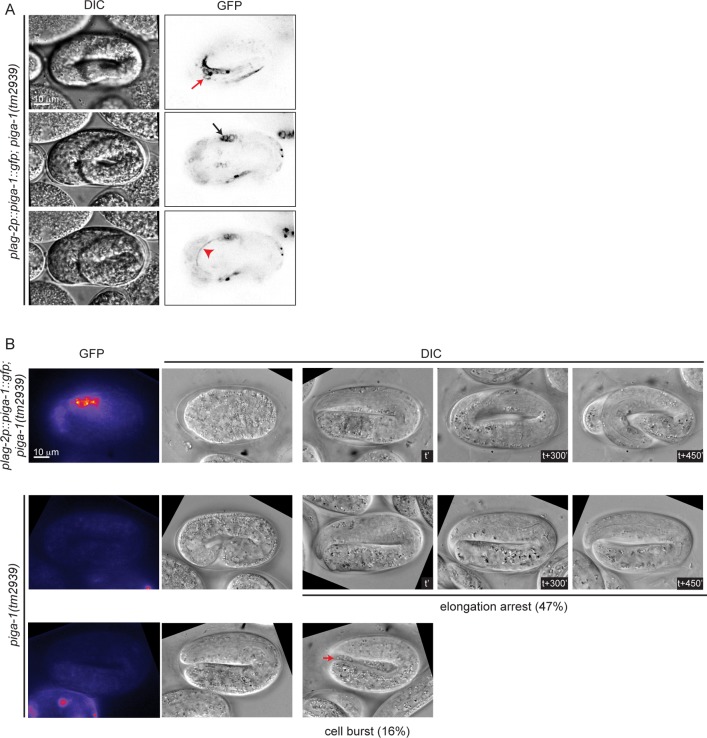
Loss of function of piga-1 shows similar phenotypes to pigv-1(qm34) mutant embryos.(A) plag-2 promoter drives piga-1 expression ubiquitously in various tissues: epidermis (top panel), intestine (middle panel) and excretory canal (bottom panel). (B) Loss of PIGA-1 expression results in elongations defects. Embryos were dissected from gravid adults expressing plag-2::piga-1::gfp and examined for their expression and phenotypes during embryogenesis. Those retaining PIGA-1::GFP expression elongate and hatch (top panel), whereas ~50% of embryos losing PIGA-1::GFP expression arrest during elongation with or without rupture (middle and lower panels).